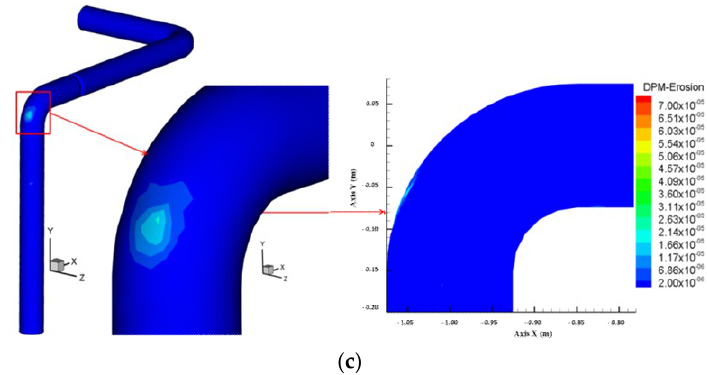
Figure 13. Erosion rate contours of gas–solid two-phase flow pipeline for different pipe diameters with 30% of the throttle valve opening. ( a ) DN80; ( b ) DN100; ( c ) DN150.